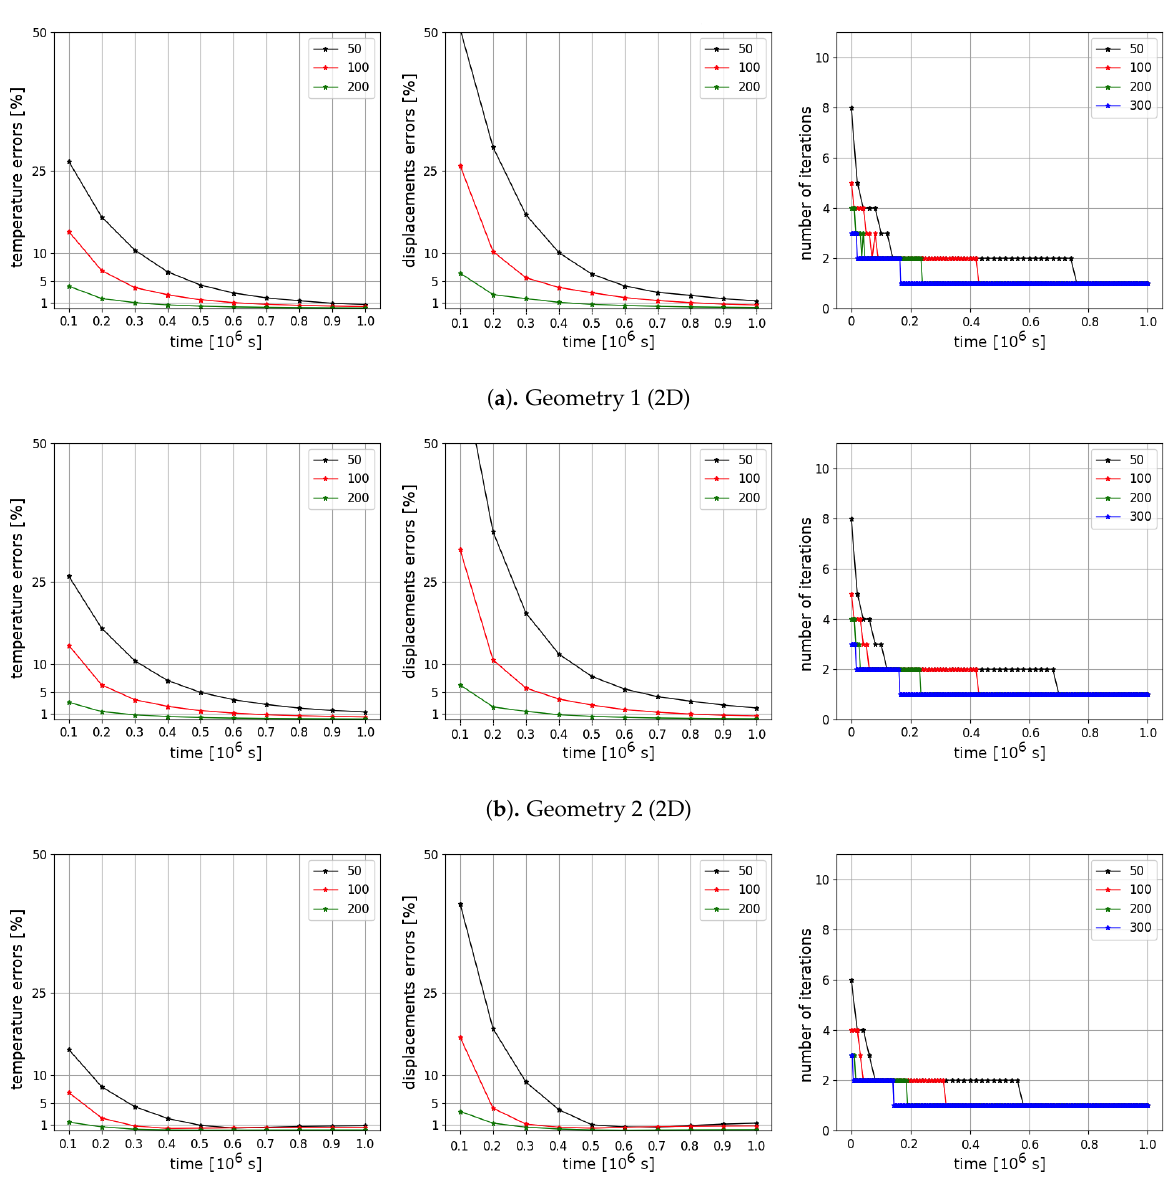
Figure 9. Test 2 for a two-dimensional problem. Results for a solution using Picard iterations with a different number of time steps t m , m = 50,100, 200. Relative errors in % for temperature and displacements for 10 time layers (first and second columns). Number of Picard iterations by time (third